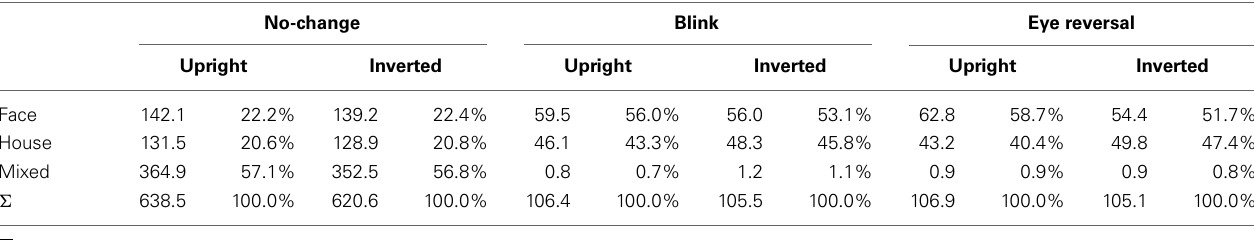
Table 2 | Frequencies of dominance epochs for rivalry of faces versus houses ( N =